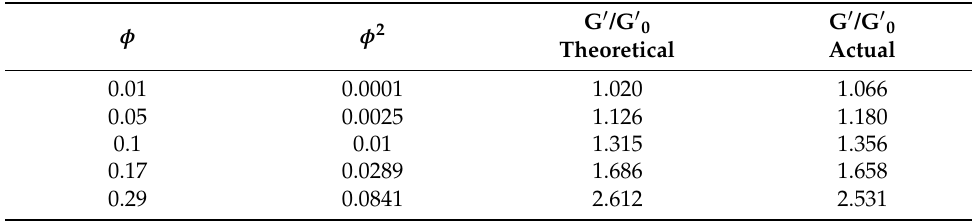
Figure 5. G (cid:48) /G (cid:48) 0 vs. φ (filler volume fraction)—actual vs. theoretical. Table 2. Actual and theoretical values of G (cid:48) /G’ 0 at different filler volume fractions. φ φ